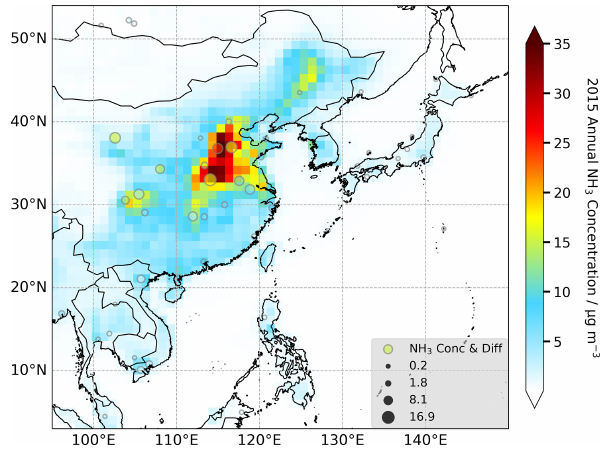
Figure 5. Modelled and measured 2015 annual mean NH 3 concen- trations in East Asia and Southeast Asia. Measurements are from the China NNDMN and East Asia EANET networks. Monitoring sites are indicated by circles whose colour represents the measured concentration and whose diameter (see inset legend) represents the absolute difference between model and